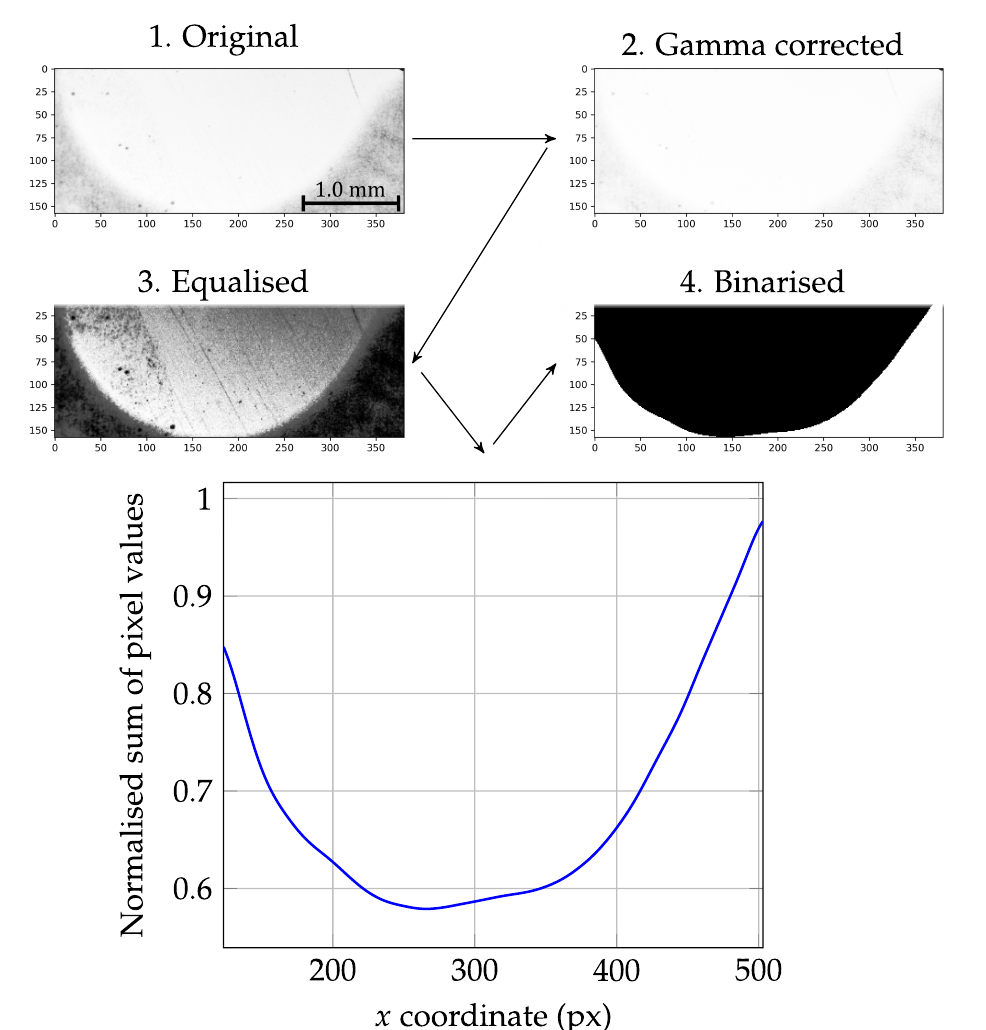
Figure 10. Stages associated with the segmentation of the diluted zone (example shown corresponds to track